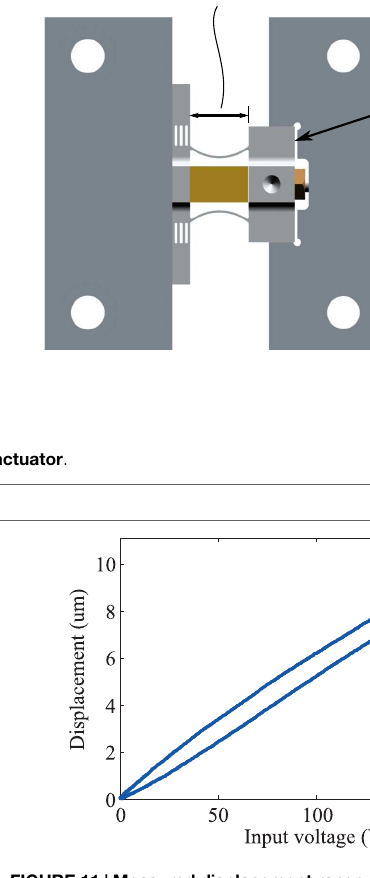
FIGURE 11 | Measured displacement range of the nanopositioning stage (Yong, 2016)